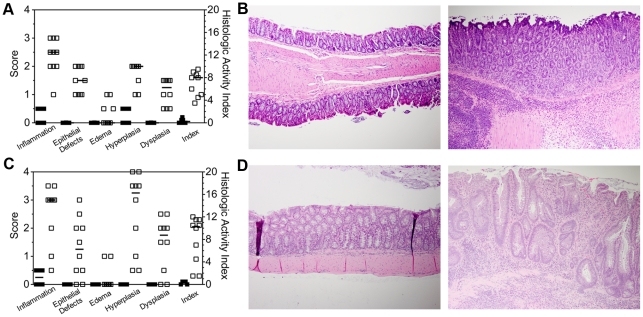
Marked colitis in C. rodentium infected and aged TLR4−/− x IL-10−/− (DKO) mice colonized with Helicobacter spp.Histological scores for inflammation, epithelial defects, edema, hyperplasia, and dysplasia in the colon for uninfected (Cr−, ▪) and C. rodentium infected (Cr+, □) mice at 14 DPI (A) and Helicobacter spp. negative (Hsp−, ▪) or positive (Hsp+, □) aged DKO mice (C). All scores were summed to form the histological activity index for individual mice. All pairings are *** P<0.0001 by Mann-Whitney test. (B) Representative H&E stained colon section from Cr− (left panel) and Cr+ (right panel) mice at 14 DPI. (D) Representative H&E stained colon section from Hsp− (left panel) and Hsp+ (right panel) DKO mice. Original magnification 100×.